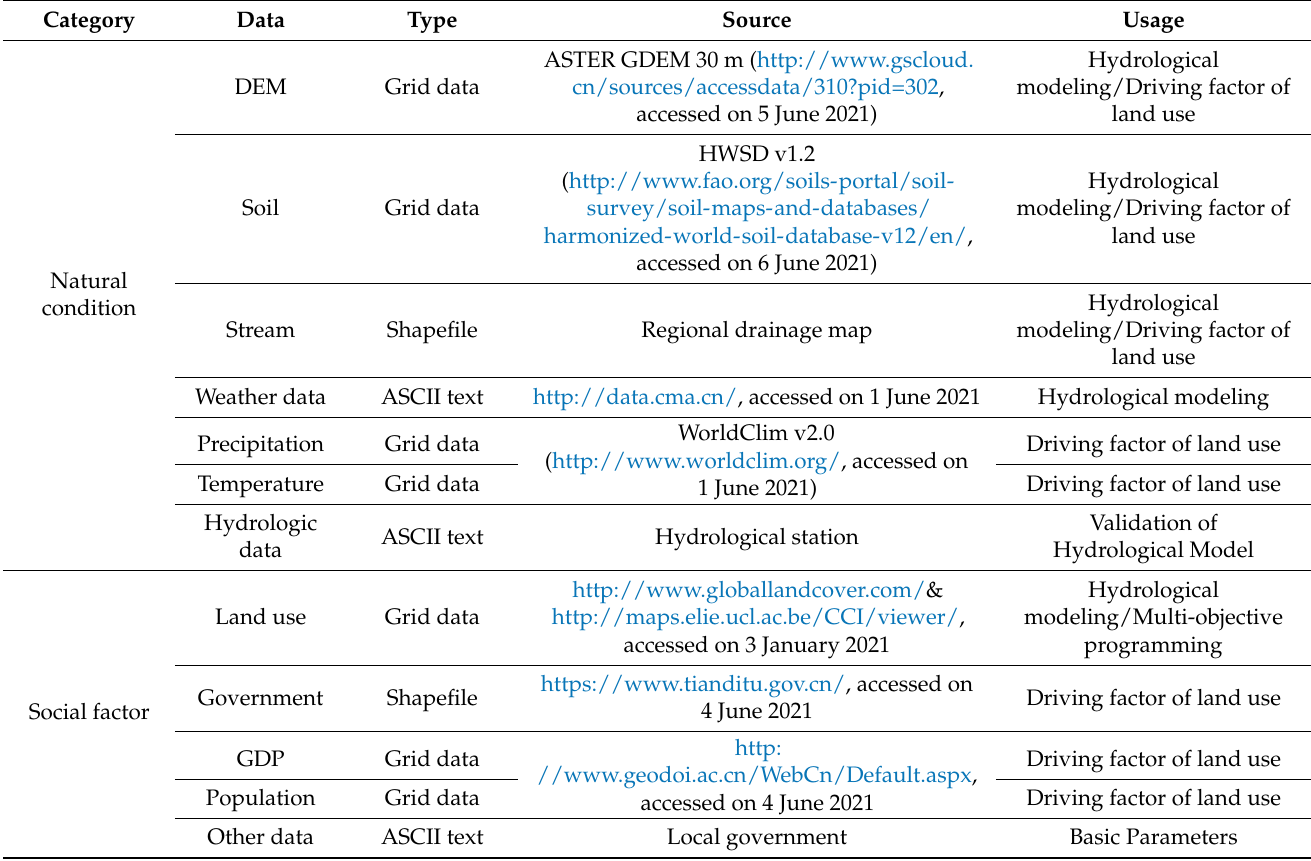
Table 4. Data sources and a detailed explanation of their usage.